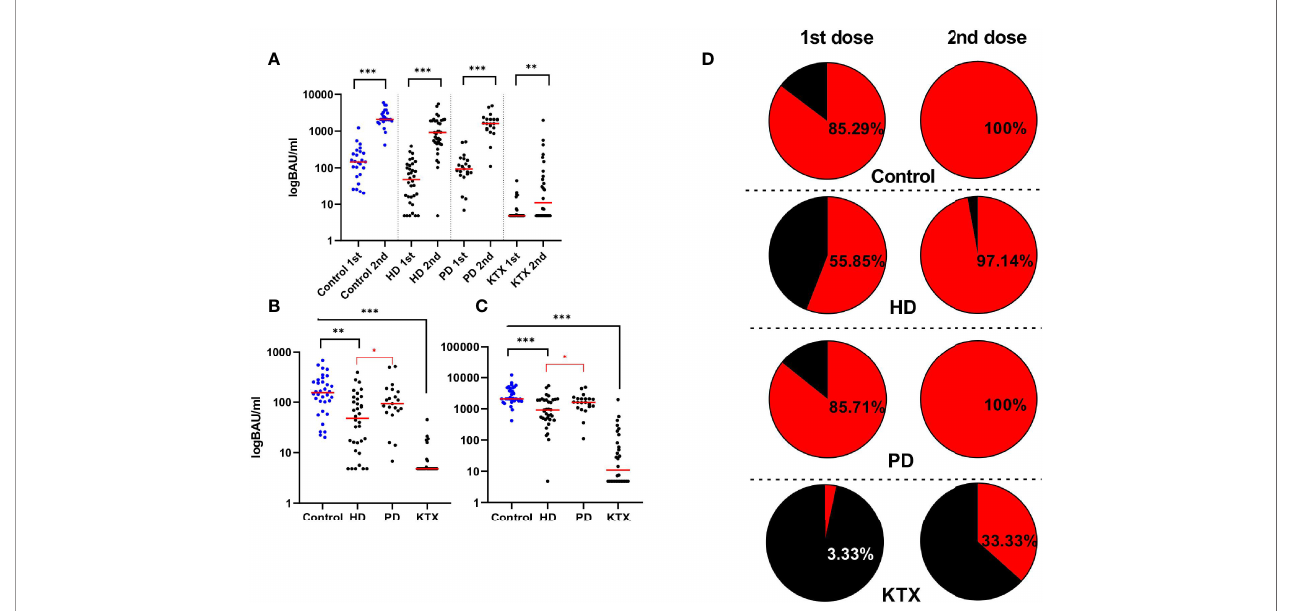
FIGURE 2 | The level of anti-S IgG (BAU/ml) and the percentage of seroconversion rate after the BNT162b vaccine. (A) Increase in anti-S IgG antibodies (BAU/ml) after the second dose of the BNT162b2 vaccine in all analyzed groups. Four sections based on the type of the group are shown: control, HD, PD, and KTX. Both antibody titers (BAU/ml) after the fi rst (1st) and the second (2nd) are presented. The red line indicates the median. Statistical comparisons across groups were performed with the Kruskal – Wallis test. In control and HD and PD groups, we observed the highest increase in anti-S IgG after the whole course of vaccination, while in the KTX group, the antibody production was particularly diminished. (B) Antibody levels (BAU/ml) after the fi rst dose of vaccine in control, HD, PD, and KTX. The control group had the highest anti-S IgG; however, signi fi cant results with the performance of the Kruskal – Wallis test were obtained between control and HD and KTX groups. The KTX group had the lowest response, and statistical signi fi cance was present between this group and all other research participants. Among dialysis patients, the PD group had signi fi cantly higher anti-S IgG compared to HD patients. The same conclusions were made after the second (C) dose of vaccine where the control and PD groups had the higher response in comparison with the HD and KTX groups. (D) On the left: seroconversion rate after the fi rst dose, on the right: seroconversion rate after the second dose. The cut-off for the positive seroconversion rate for anti-S IgG was ≥ 39 BAU/ml. The circle divides patients into: responders (red — positive anti-S IgG titer after vaccine) and non-responders (black — patients without anti-S IgG). The detailed data (percentage) collects the number of patients with positive seroconversion. HD, hemodialysis; PD, peritoneal dialysis; KTX, kidney transplant